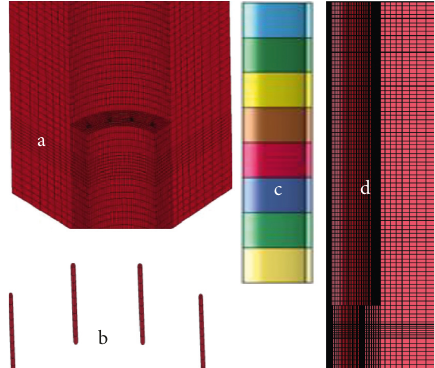
Figure 5: Finite element model of the shaft: (a) local magnification near the heading face; (b) magnification of the explosive grains; (c) eight molds of the shaft lining; (d) structure of the surrounding rock of the shaft